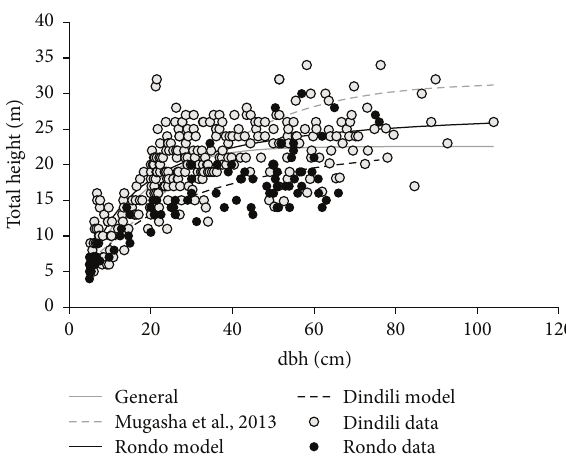
Figure 2: Pattern of observed and predicted ht against dbh of the selected